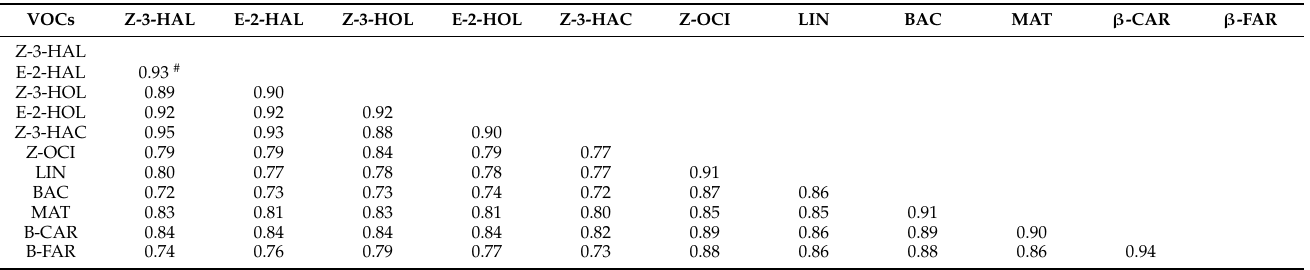
Table 2. Correlation coefficients between particular pairs of GLVs emitted from R. confertus after DJA